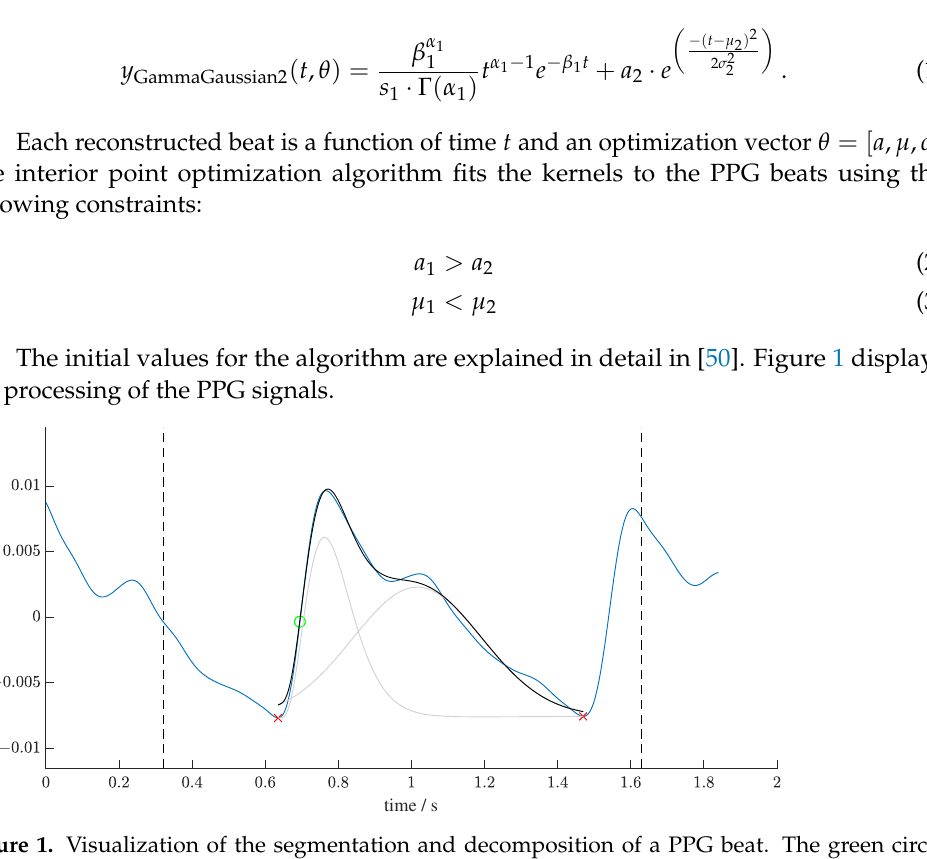
Figure 1. Visualization of the segmentation and decomposition of a PPG beat. The green circle marks the detection point from the algorithm of Lazaro et al. [49]. The black dashed lines display the interval around the detection point in which the minima (red crosses) are searched. The beat between these minima is then decomposed into two kernels (light grey). The sum of the kernels is the recomposed beat (black